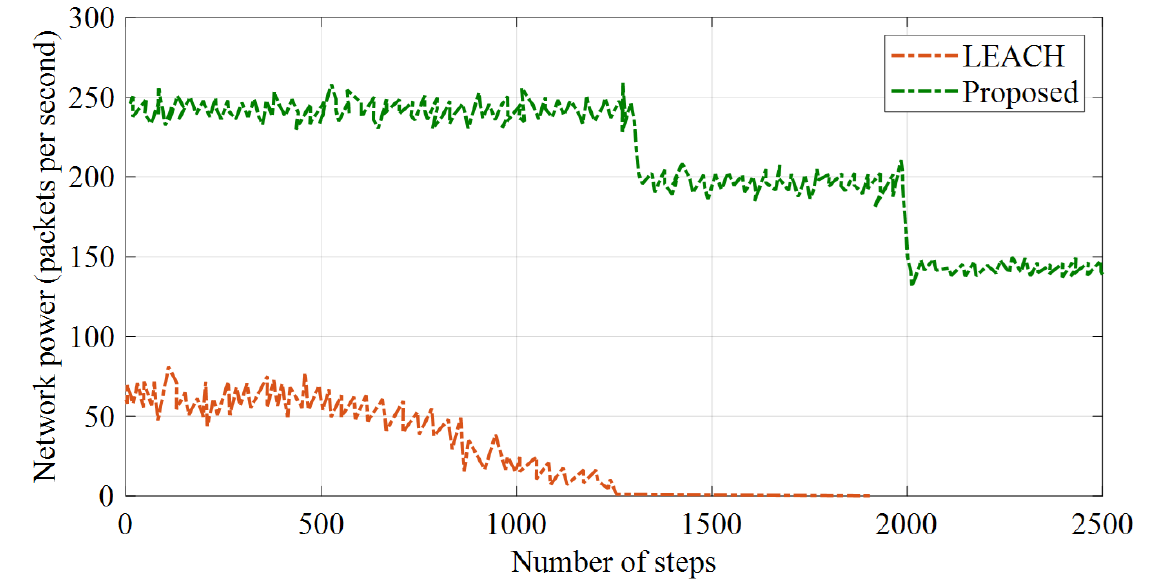
Figure 9. Throughput-received packets from the network.